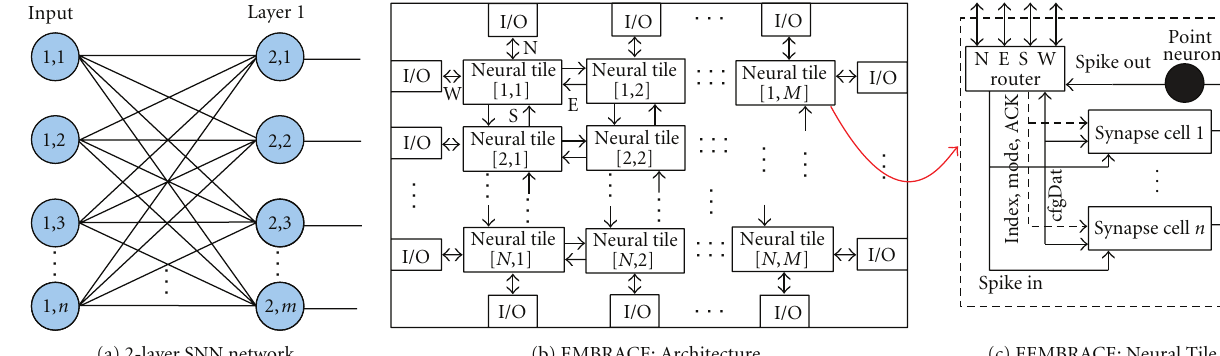
Figure 1: Architecture overview.